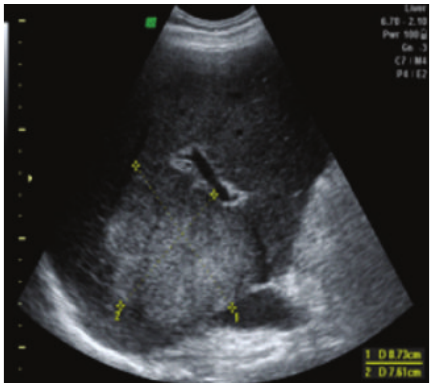
Figure 1: US of the liver after electric shock. US image of the liver shows the presence of hyperechogenic, homogenous, nonlinearly shaped focal lesion, situated in segments VIII and V, sized 7 cm × 8 cm.